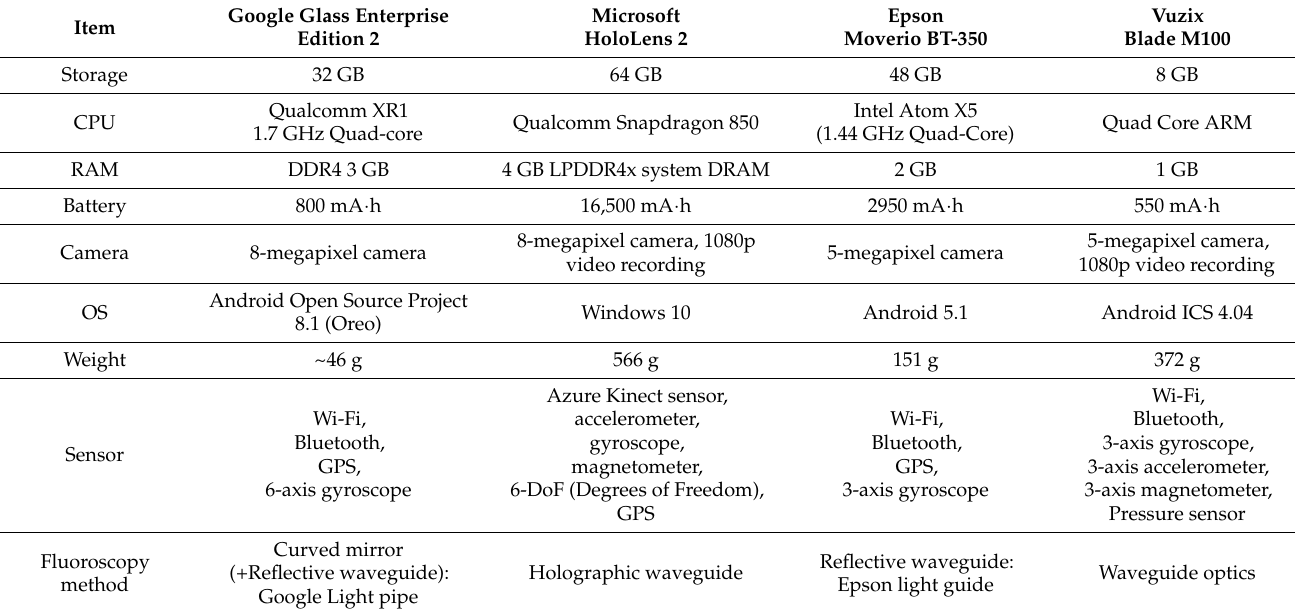
Table 7. Specification of Vuzix blade [70], Google’s Glass Enterprise Edition 2 [71], Epson’s Moverio BT-350 [72], and Microsoft’s HoloLens 2